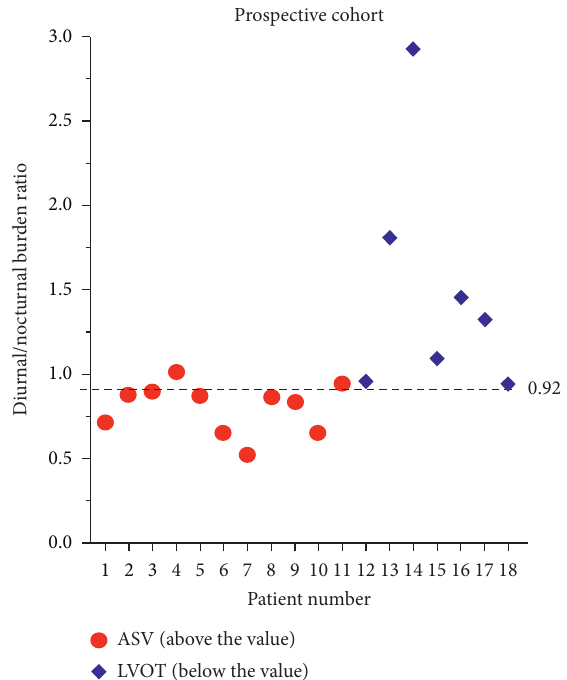
Figure 6: Scatter plot of the diurnal/nocturnal PVC burden ratio in the prospective cohort consisting of ASV and LVOT PVCs. Using a 0.92 cutoff successfully predicted PVC origin in 16/18 cases in a prospective cohort. ASV, aortic sinus of Valsalva; LVOT, left ventricular outflow tract; PVC, premature ventricular